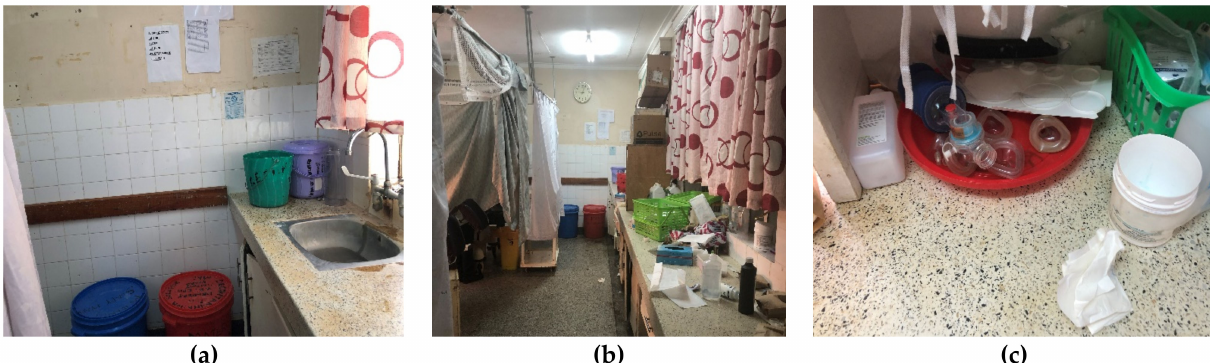
Figure 5. Reprocessing of neonatal equipment in a hospital in rural Kenya. ( a ) Reprocessing area with buckets for different steps; ( b ) reprocessing area at the end of hallway, with active labor and delivery beds in the image to the left; and ( c ) reprocessed neonatal resuscitation equipment in the red tray, awaiting patient use. Images A. White, 2019.